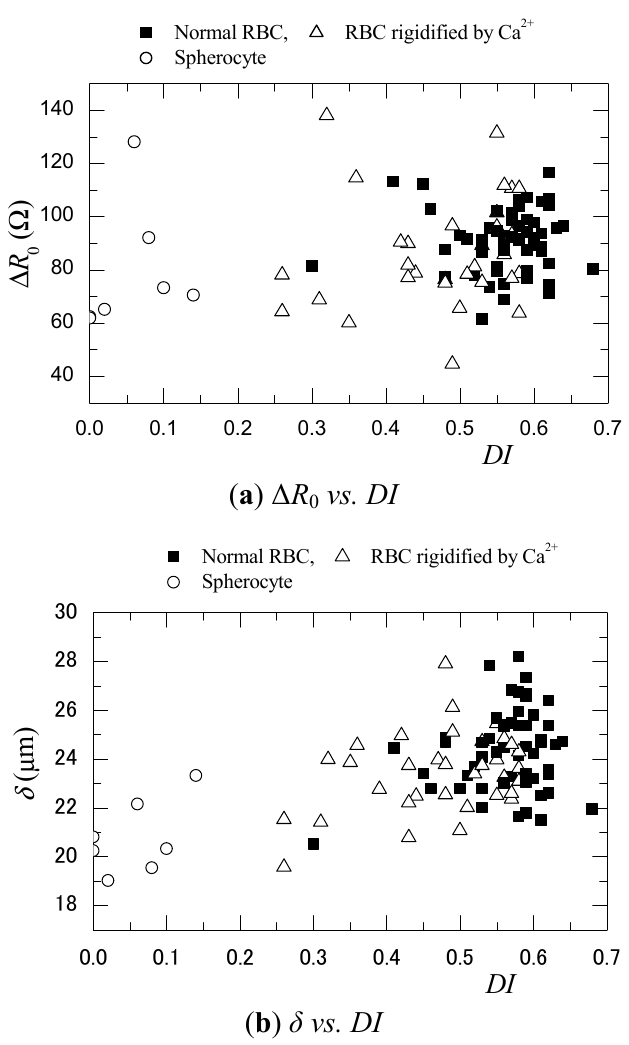
and δ with the deformation index DI 0